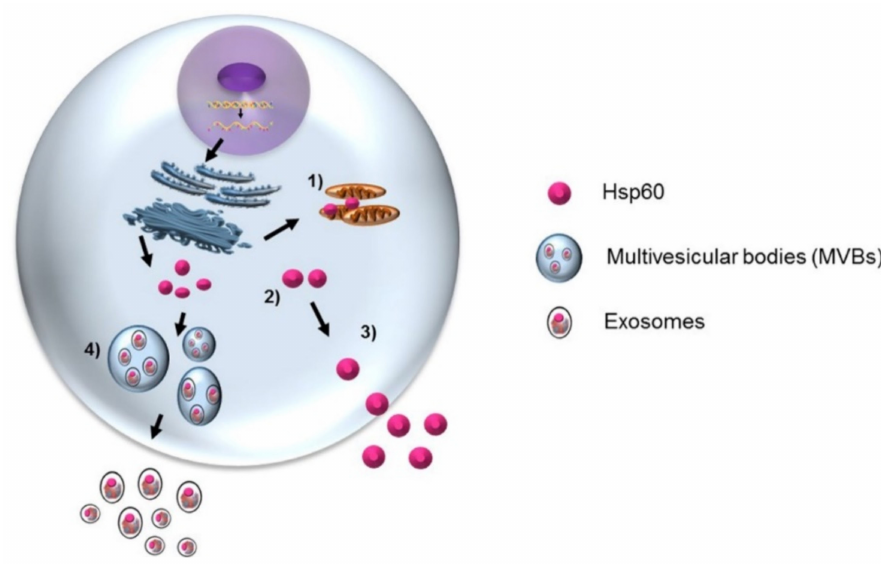
Figure 2. Hsp60 is classically a mitochondrial molecule (1) but it is found also outside the organelle, and various other places, such as in the cytosol (2), plasma-cell membrane, intercellular space, and blood. Its functions are therefore varied in physiology and pathophysiology, depending on where it